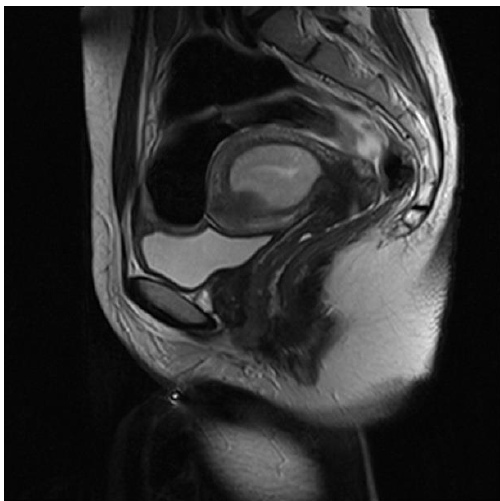
Figure 7. Physiologic transient myometrial contraction. Sagittal T2-weighted image showing focal low-signal-intensity bulging of the myometrium that mimics adenomyosis. This finding disap- peared on subsequent T2-weighted images.